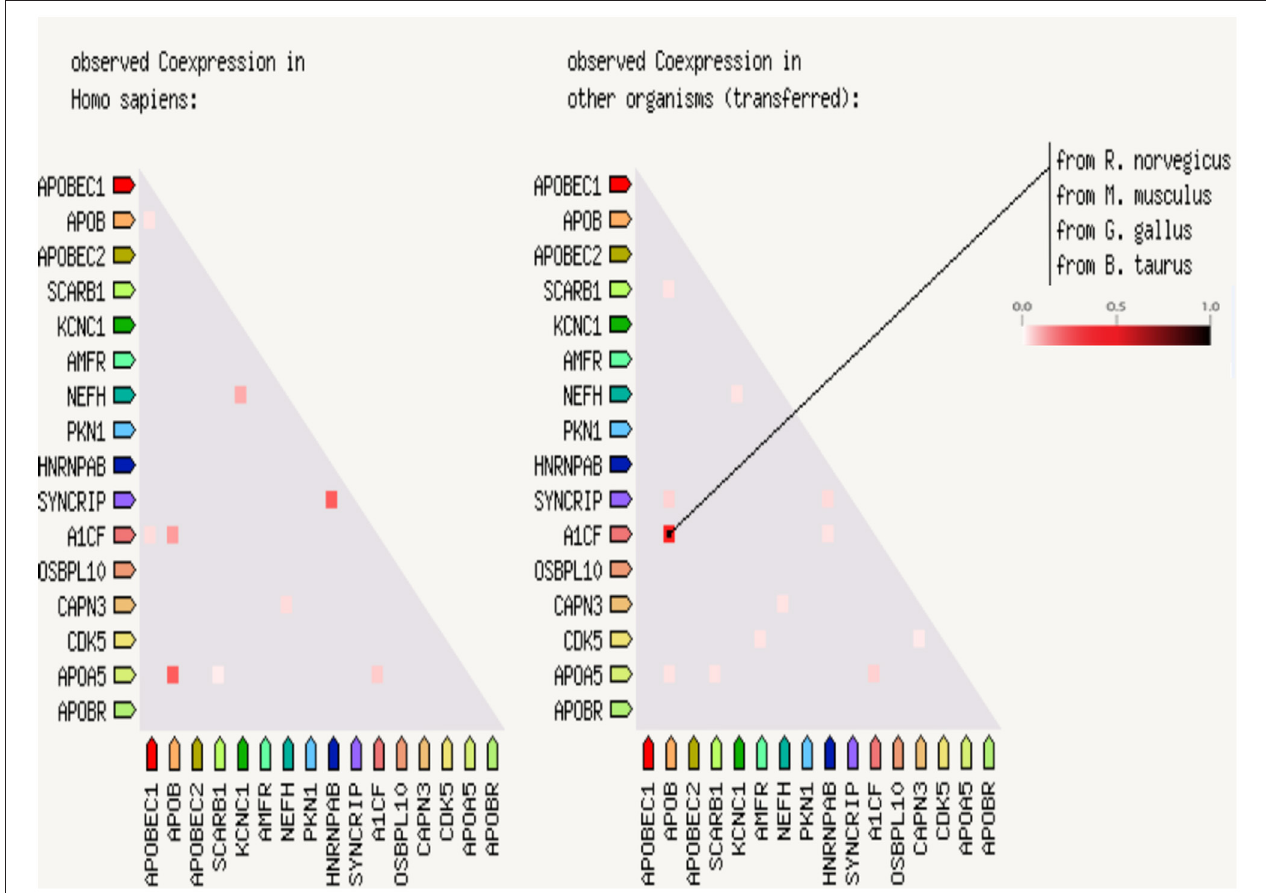
FIGURE 3 | Coexpression scores based on RNA expression patterns and protein co-regulation. In the triangle-matrices above, the intensity of color indicates the level of confidence that two proteins are functionally associated, given the overall expression data in the Homo sapiences and other organisms. TABLE 2 | Clinical phenotype of patients with mutation site of c.959G > A. Gender (male,